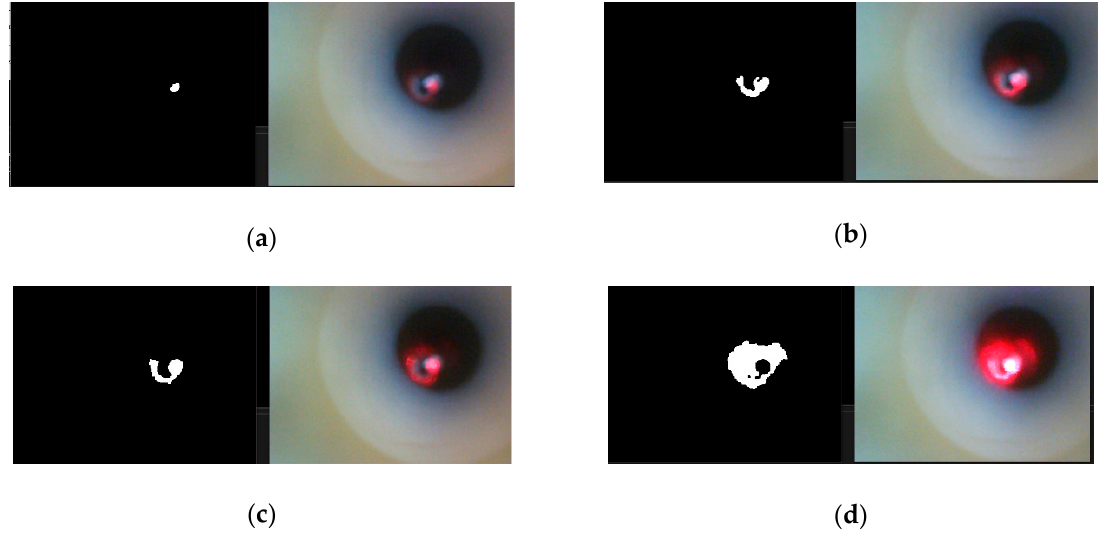
Figure 12. The image received by the CCD sensor of probe in the process of measurement: ( a ) Level with upper surface; ( b ) Half of the laser projection; ( c ) Most laser projection; ( d ) All laser projection.